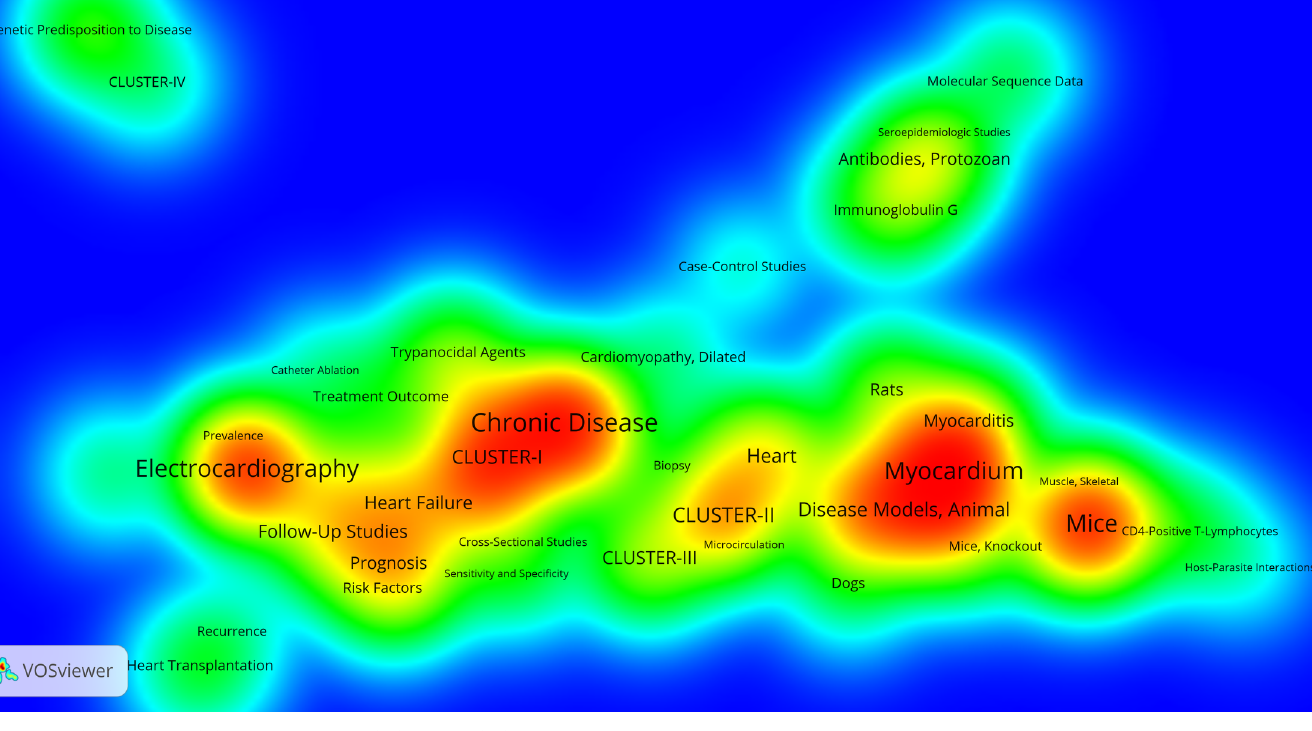
Fig 4. Network of MeSH and their association with the research